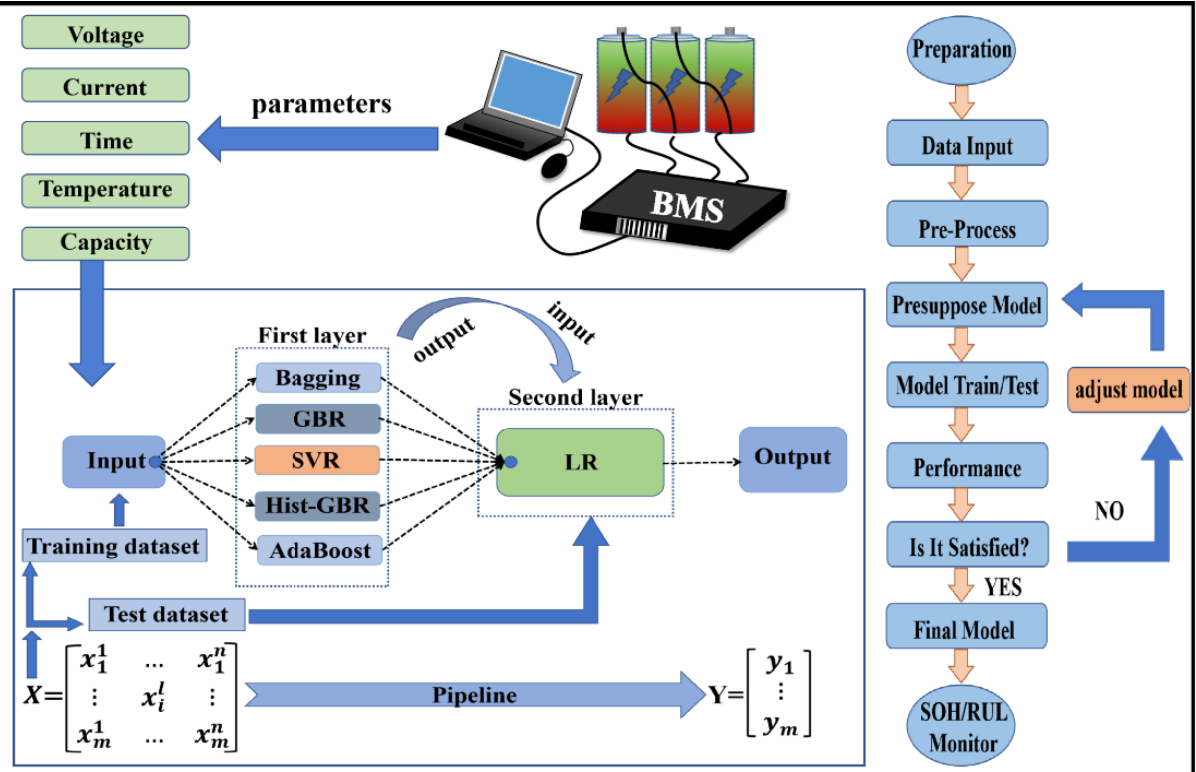
Figure 1. The frame and workflow of the SR model. The estimators, including bagging, gradient boosting regression (GBR), support vector regression (SVR), Hist-GBR, and AdaBoost, were integrated into the first layer. The linear regression (LR) method was used in the second layer.